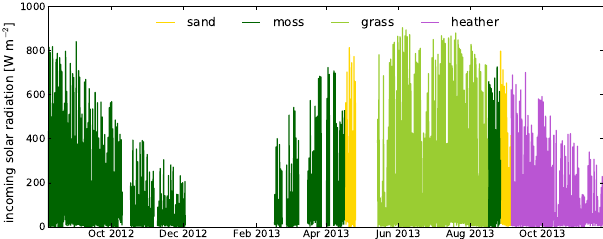
Figure 3. Measured incoming solar radiation R s ↓ at the four differ- ent surfaces. Periods with snow cover or sensor maintenance were omitted.